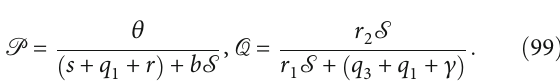
0 by 3D plot and the contour of